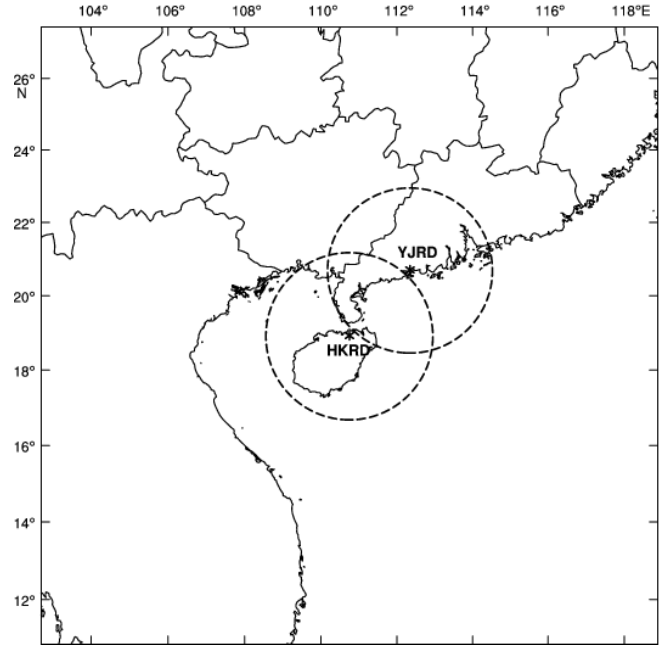
Figure 1. The model domain and the coverage of the two radars.